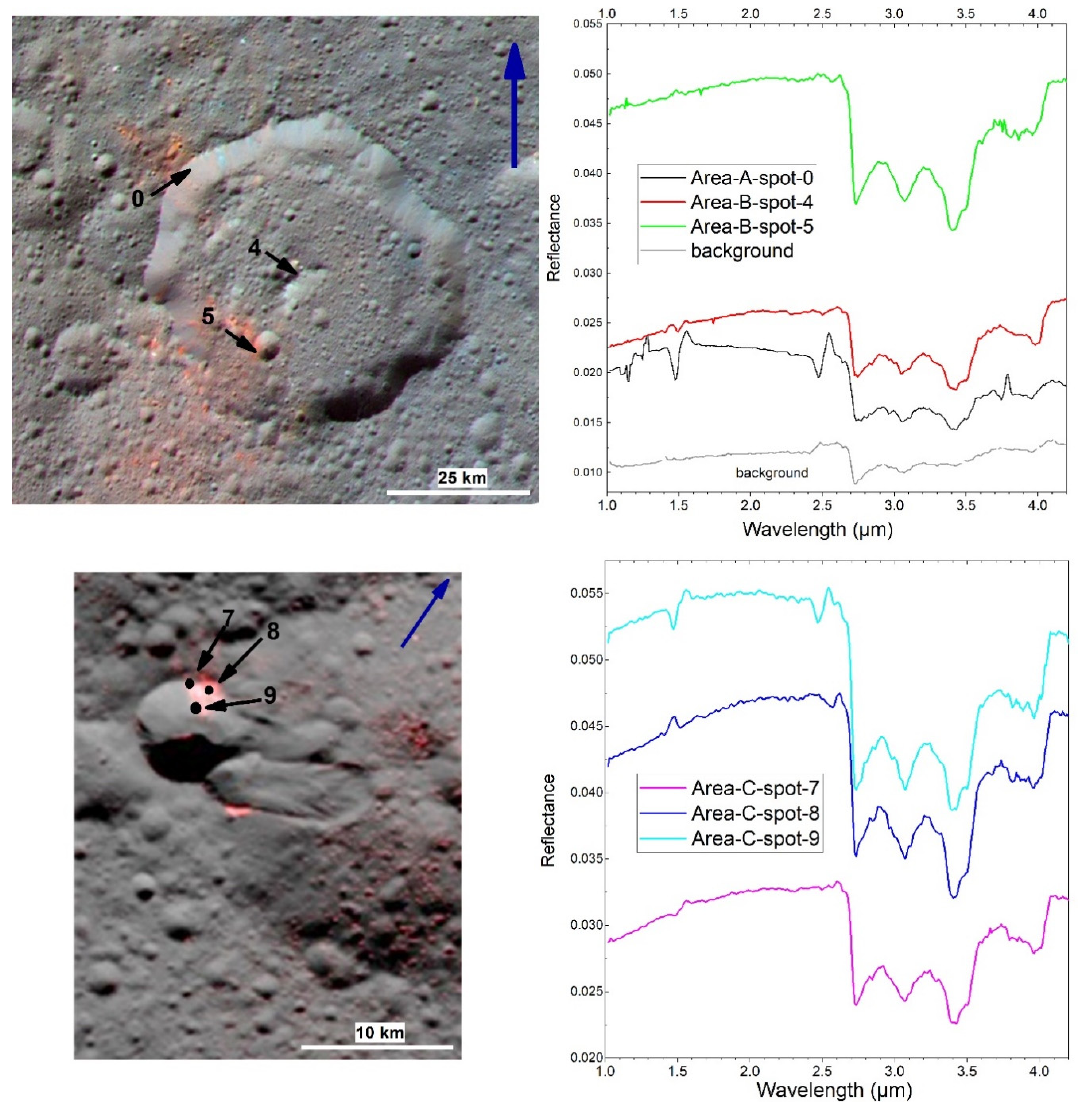
Figure 2. Left: enhanced color images from the Ernutet (top) and Hakumyi (bottom) crater areas, from the framing camera (FC). Organic matter is revealed by the reddish colors in these images (adapted from De Sanctis et al., [15], original Figure in Ref. [15]). North is indicated by the blue arrows. Right: spectra of the different organic spots, used in this study for comparison, obtained during the LAMO phase (about 200–300 m² total) and newly recalibrated (see methods and analyses section). A background spectrum from the area is shown for reference.